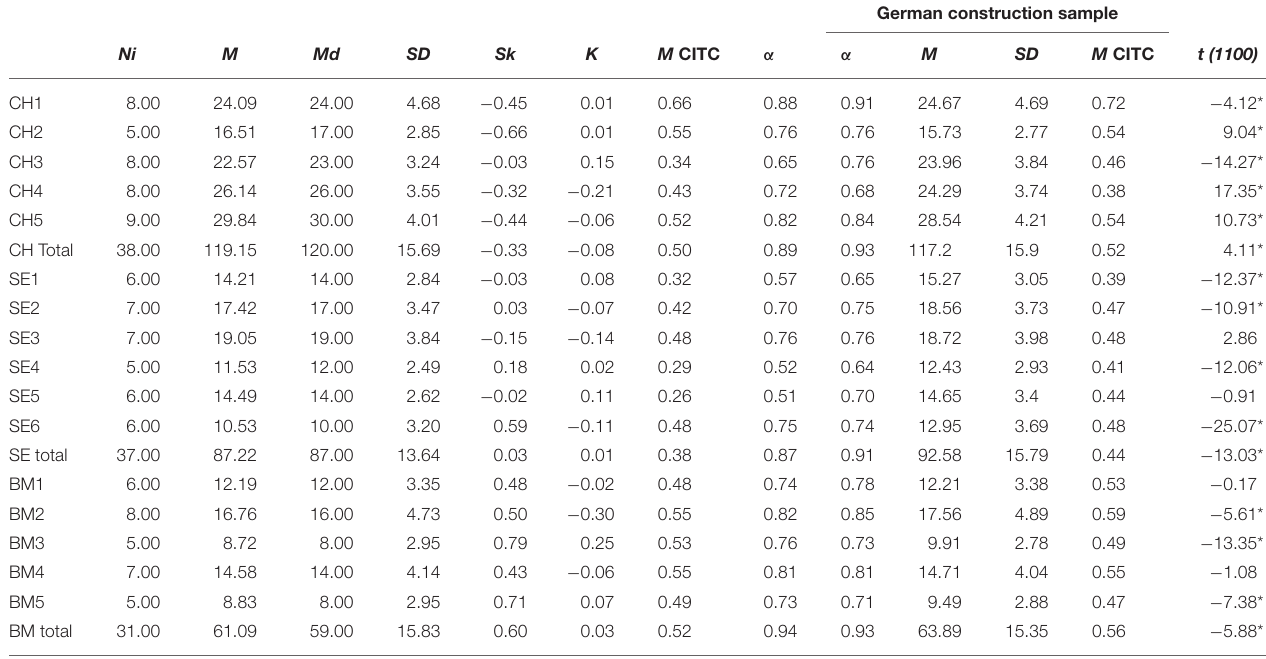
German construction